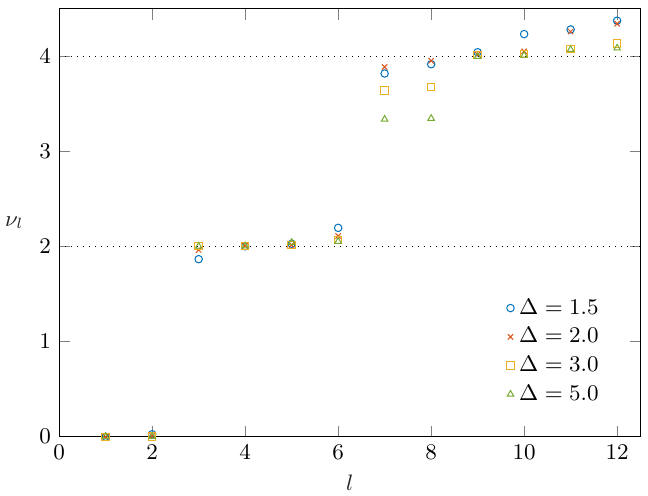
Figure 7: Scaled levels ν obtained from the reduced density matrix eigenvalues λ l at time t = 100 via Eq. (61) for different ∆